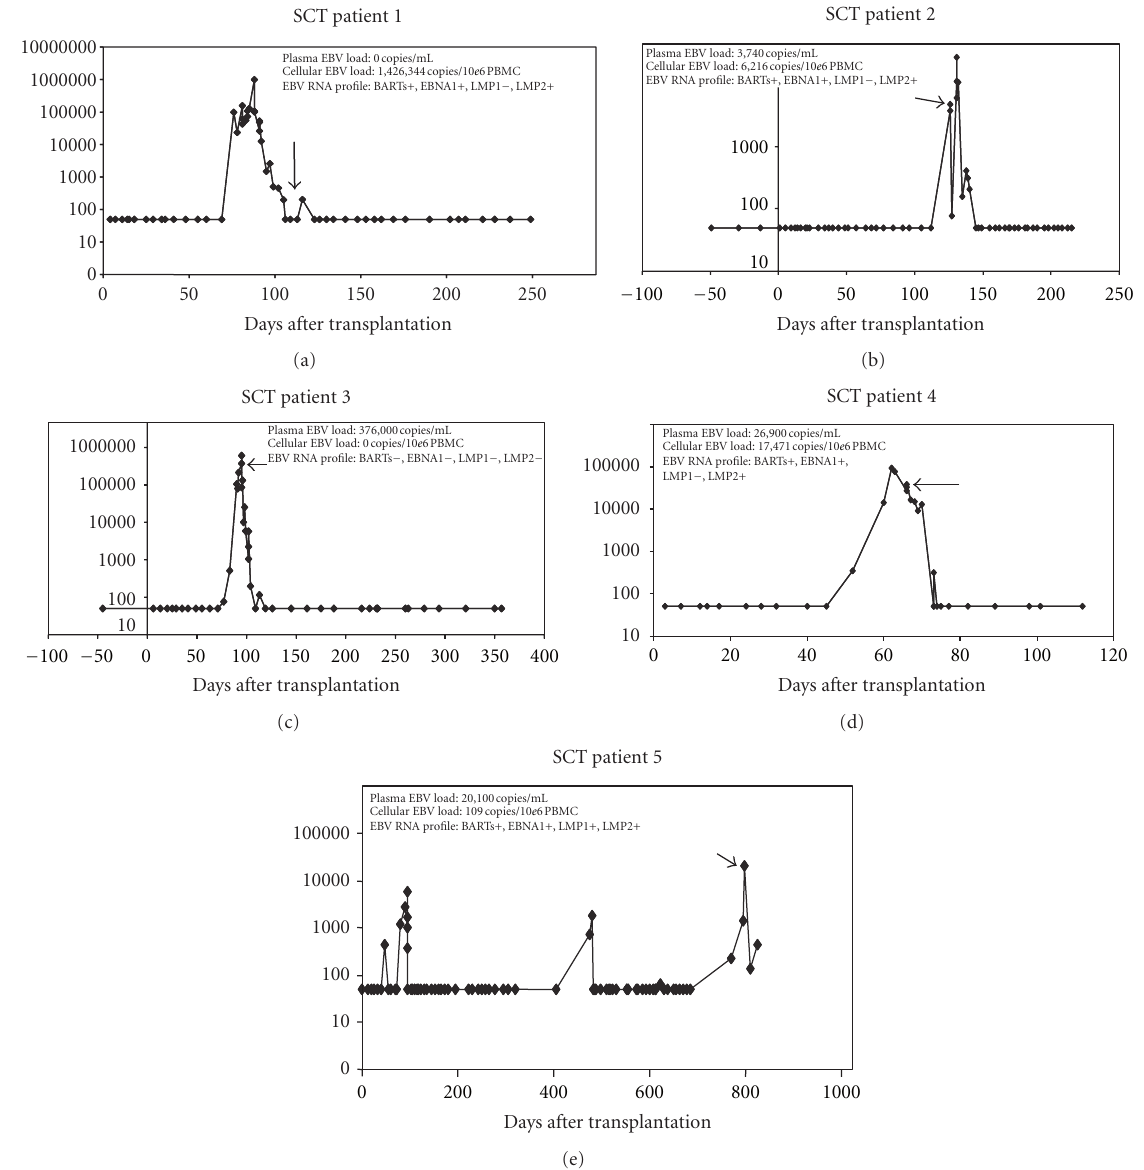
Figure 1: EBV RNA expression analysis in follow-up PBMC samples from SCT recipients in relation to plasma EBV DNA load kinetics. Viral DNA load in plasma was monitored by quantitative RT-PCR after stem cell transplantation ( y -axis). At the indicated time point viral load was determined in plasma as well as in PBMCs. Presence of BARTs, EBNA1, LMP1, and 2 RNA was analysed by RT-PCR in 10e6